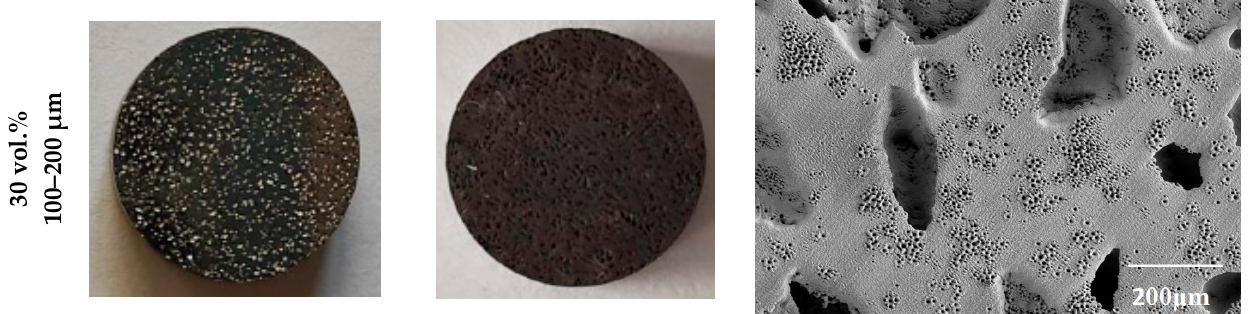
Figure 1. Optical and SEM images of some of the samples studied, before and after FS. All optical images are on the same scale, 3:1 (mm). FD: fully dense sample; 30 vol. %: sample with 30% porosity volume.